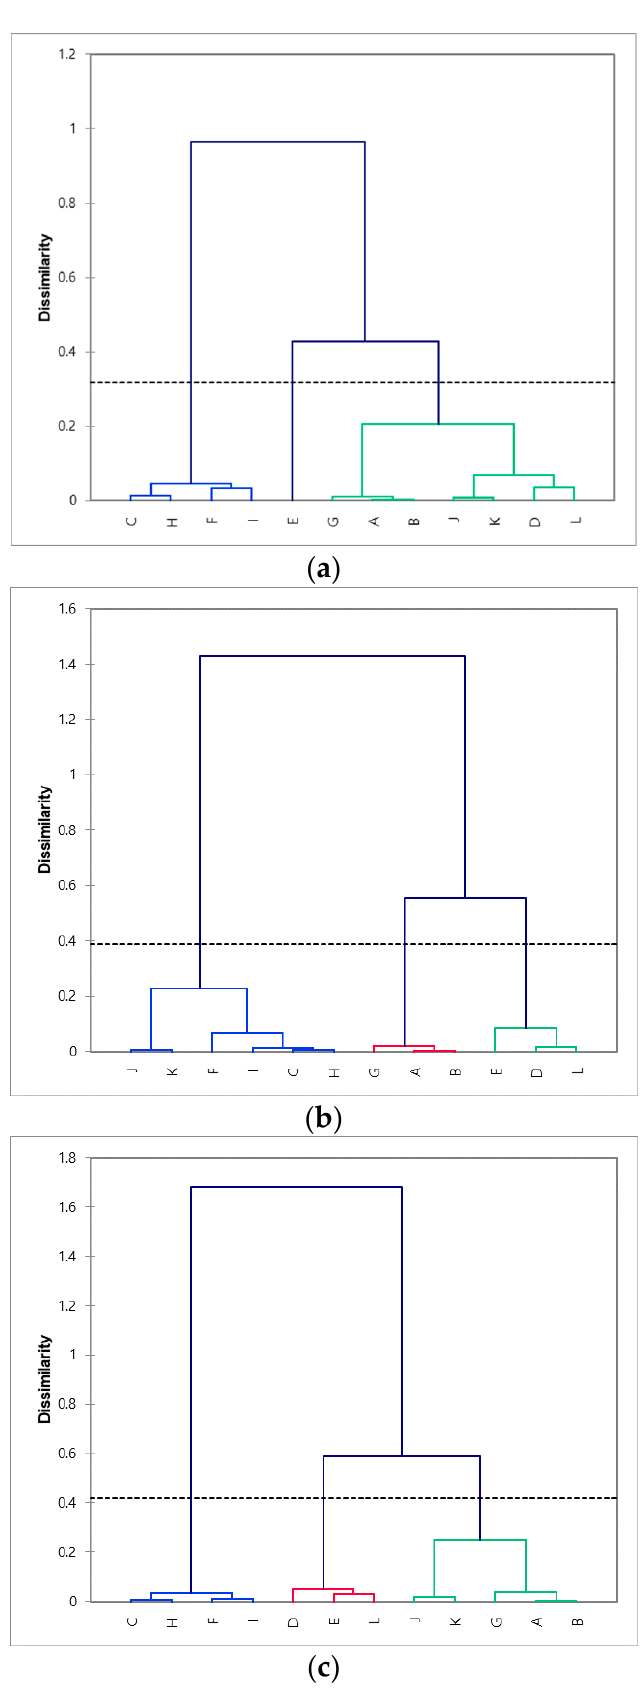
Figure 2. Dendrograms from agglomerative hierarchical cluster analysis performed on yakju samples for ( a ) CATA method, ( b ) RATA method, and ( c ) CATA-JAR method. Product codes as in Table 1.